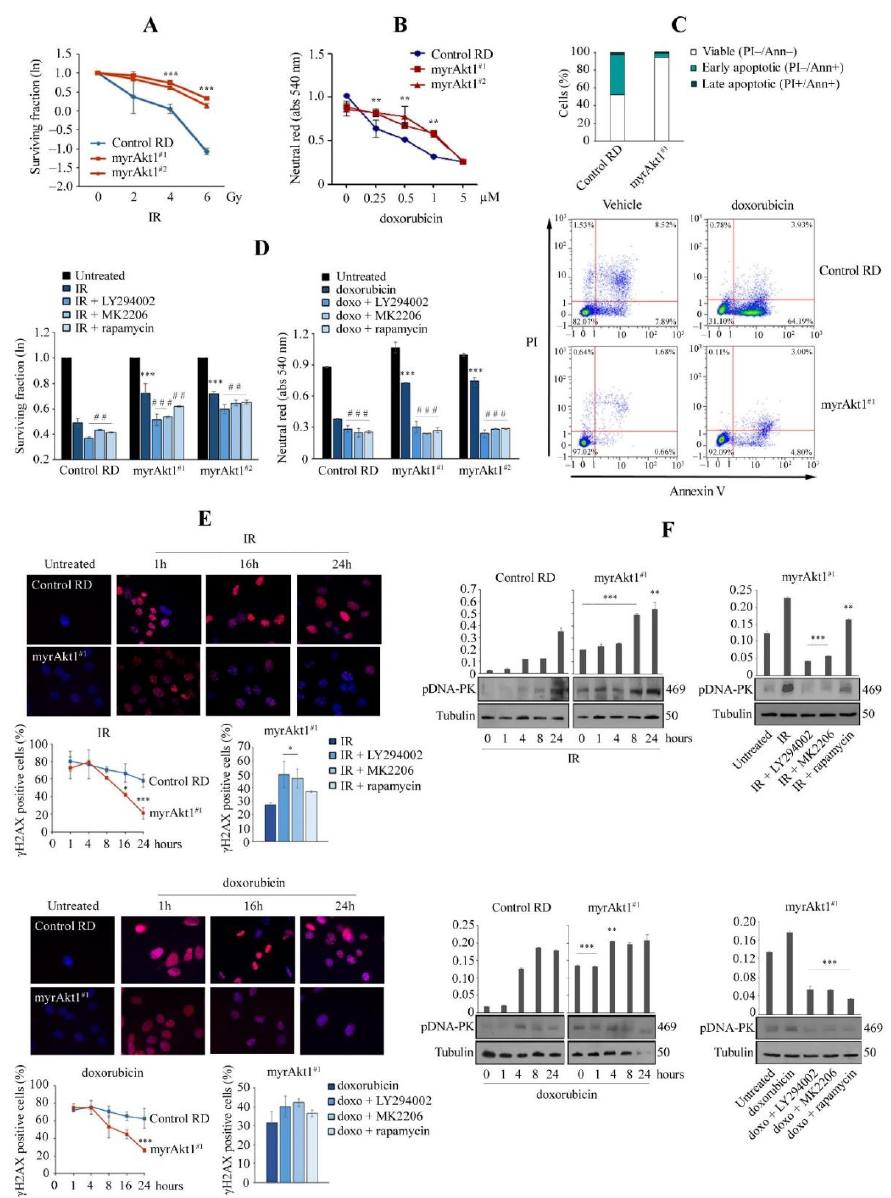
Figure 3. Analysis of apoptosis and DNA damage mechanisms in response to genotoxic stress